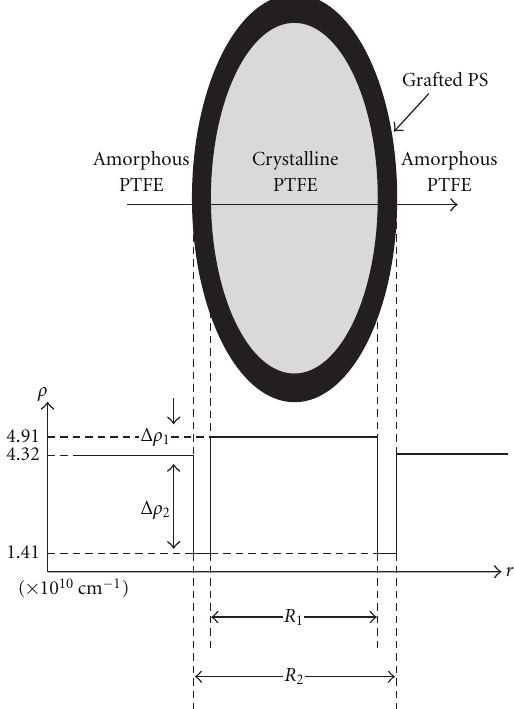
Figure 8: A schematic view showing an ellipsoidal PTFE microcrys- tal covered by PS (gray and block parts correspond to crystalline and grafted PS regions, cross-sections for which are R 1 and R 2 , resp.) Coherent scattering length densities ( ρ ) for amorphous and crystal- line PTFE and grafted PS regions and their gaps ( Δ ρ 1 and Δ ρ 2 ) are also